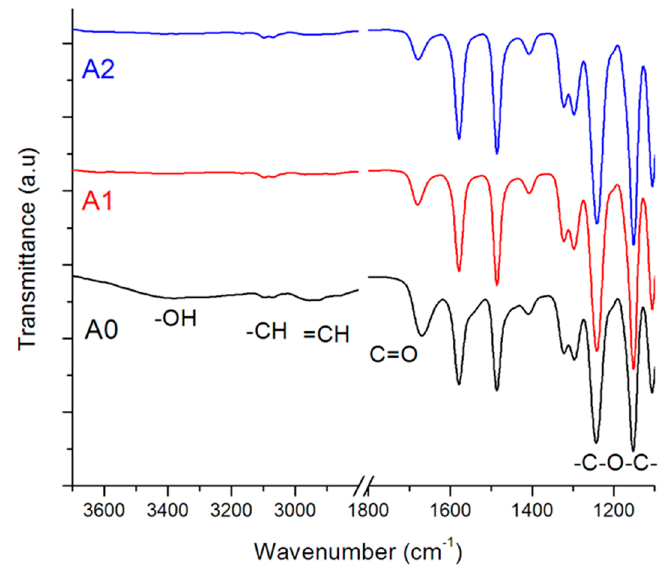
Figure 1. ATR-FTIR spectra of the membranes: PMAA-PES (A0), Pd@Fe@HPEI/PMAA-PES (A1), and Pd@FeAg@HPEI/PMAA-PES (A2).